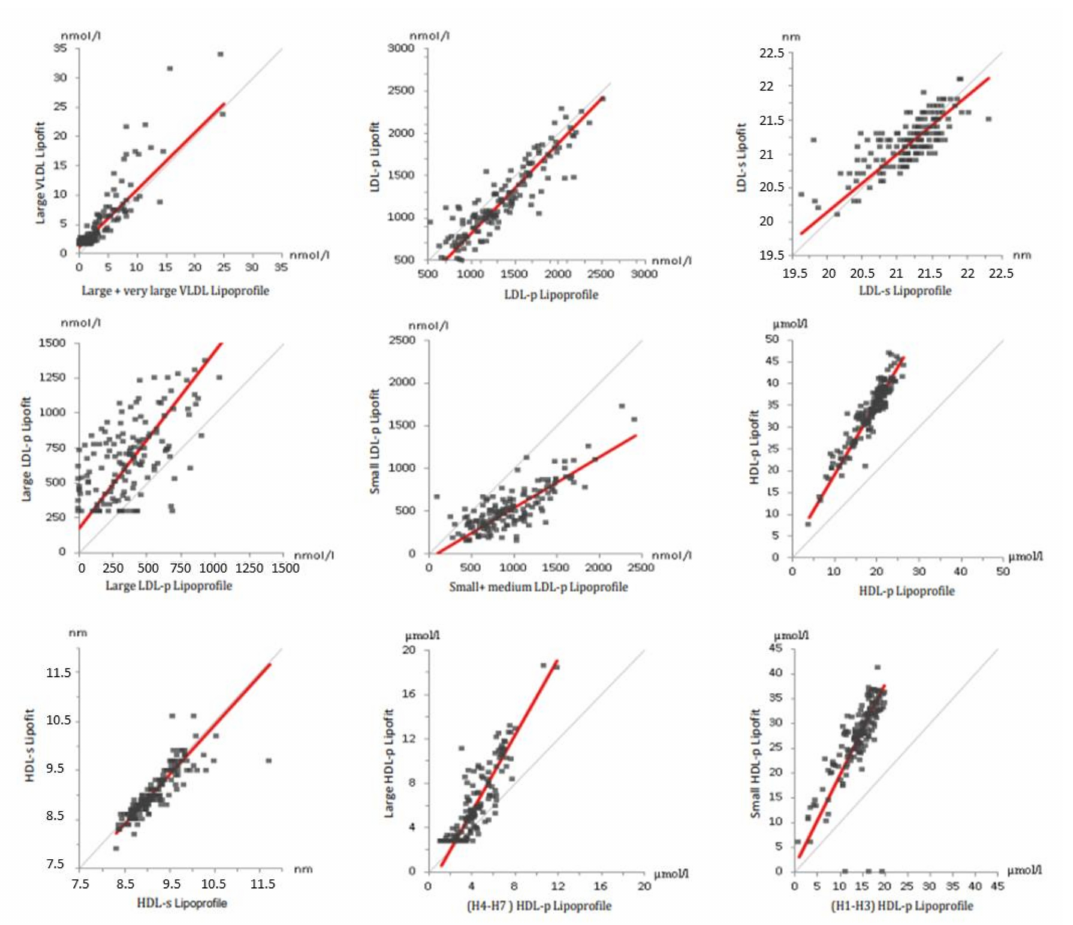
Figure 3. Comparison of lipoprotein particles between the lipoprofile and lipofit methods. The figures show the Passing–Bablok regression for large and very large VLDL (top left ), LDL-p (top middle), LDL-s (top right ), large LDL-p (middle left ), small and medium LDL-p ( middle ), HDL-p (middle right), HDL-s (bottom left ), large HDL-p (bottom middle), and small HDL-p (bottom right ). The respective slopes of the regression lines (red) were 0.980 (large VLDL-p), 1.272 (large LDL-p), 0.593 (small and medium LDL-p), 1.817 (small HDL-p) and 1.722 (large HDL-p), respectively. The grey line represents the line of identity. (HDL = high-density lipoproteins. LDL = low-density lipoproteins. p = particles. VLDL = very-low-density